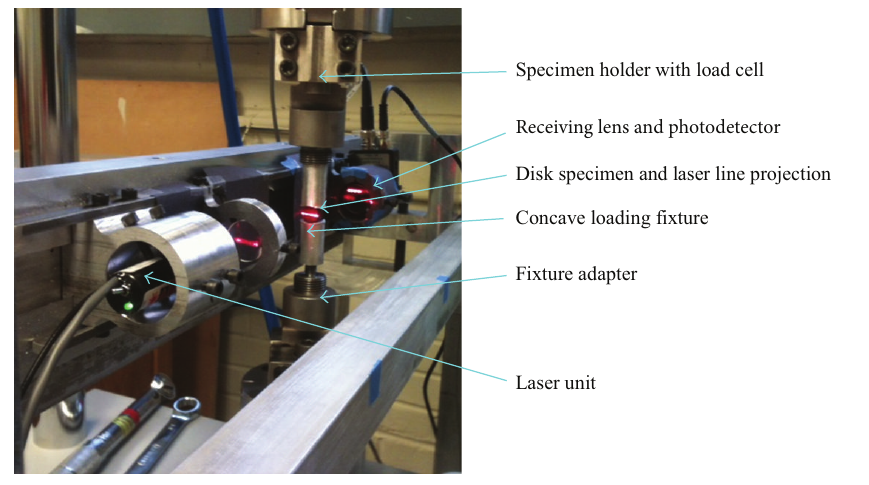
Figure 6: Quasi-static indirect tensile test setup with